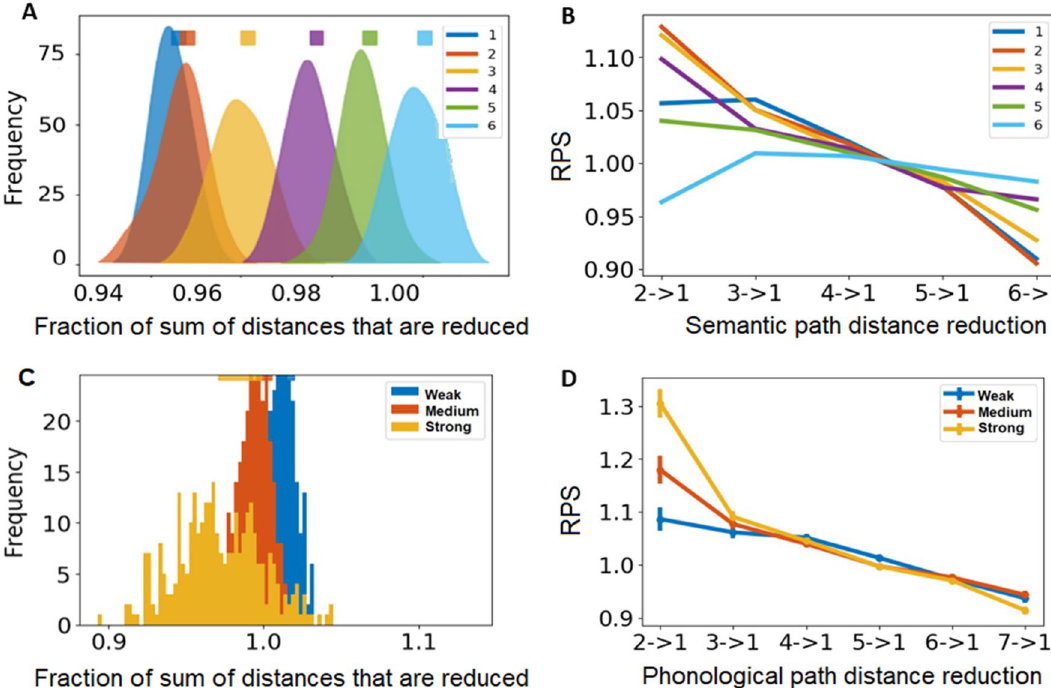
Figure 3. The effect of adding non-overlapping phonological/semantic links to the semantic/phonological layer. ( A ) The ratio between the sum of distances that were reduced in the semantic layer by adding non- overlapping phonological links of different distances and by adding randomly chosen links (adding random links corresponds to 1.00 in the x-axis). The smooth kernel histogram distribution is shown for 300 realizations. The rectangles represent the mean and standard deviation of the specific phonological-distance distributions. ( B ) Ratio between the number of semantic path distances that were reduced to a distance of one due to adding non-overlapping phonological links and the analogues for adding random links. The x-axis is the specific semantic path distances that were reduced. Y-axis: Ratio of Path Shortening (RPS). ( C ) The ratio between the sum of distances that were reduced in the phonological layer by adding non-overlapping semantic links from different strengths (weak, medium and strong) and by adding randomly chosen links. The distribution is shown for 300 realizations. The rectangles are colored according to the phonological path distance represents the mean and the standard deviation of the distributions. ( D ) Ratio between the number of phonological path distances that were reduced to a distance of one due to adding non-overlapping semantic links and the analogues for adding random links. The x-axis is the specific phonological path distances that were reduced. Y-axis: Ratio of Path Shortening